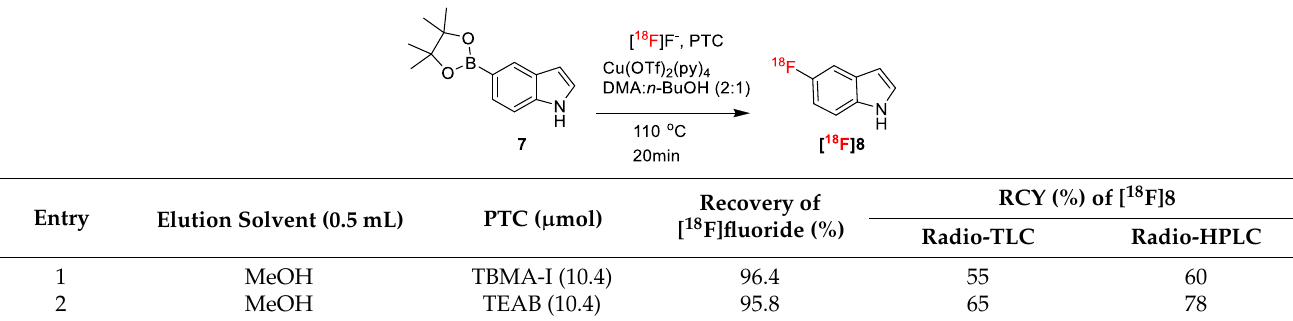
Table 4. Radiosynthesis of 5-[ 18 F]fluoro-1H-indole ( [ 18 F]8 ) from 5-indoleboronic acid pinacol ester ( 7 ) in the presence of TEAB or TBMA-I 1 .